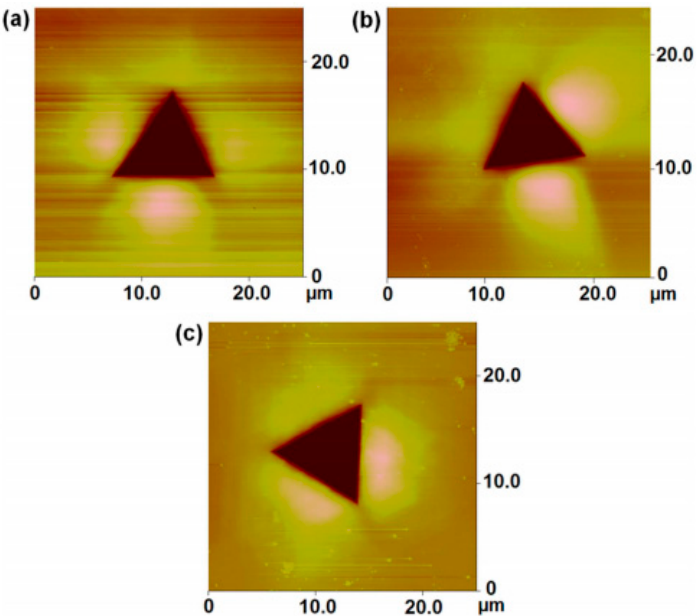
Figure 40. Atomic-force microscopy (AFM) images of the indent impressions made on a single-crystal Al workpiece with a Berkovich indenter (tip radius 200 nm) at different crystallographic orientations: ( a ) (001), ( b ) (101) and ( c ) (111) surfaces [136].